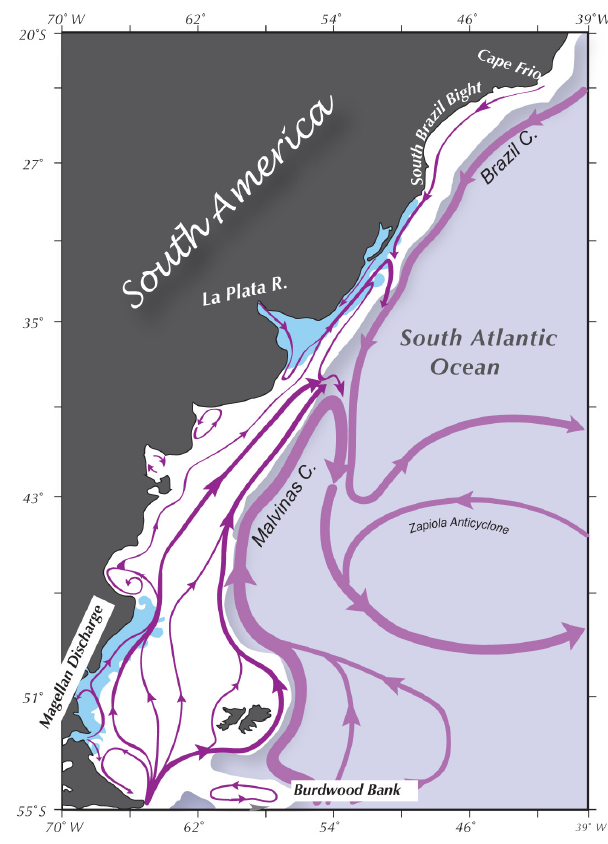
Fig. 1. Schematic representation of the depth-averaged circulation in the southwestern Atlantic region. The shelf (depths smaller than 200m) is marked by white